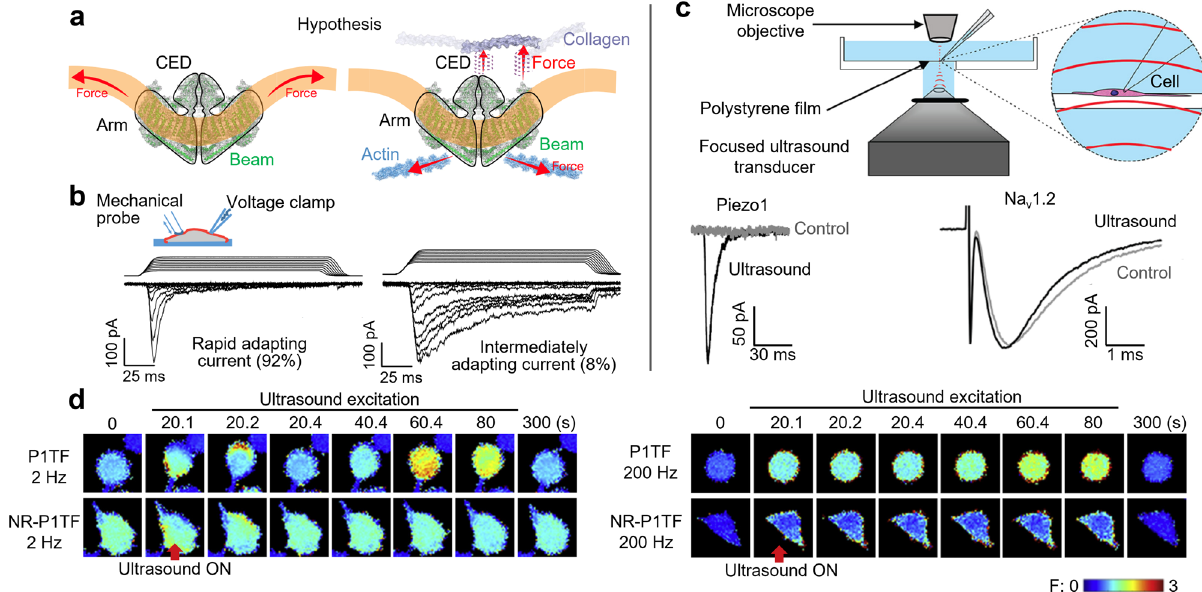
Fig. 2 Acoustic technologies for mechanobiology. Acoustic technologies are being utilized to study mechanically sensitive ion channels, such as Piezo1 and Piezo2. a Two models have been proposed for activation of the Piezo1 channel: the lateral membrane tension model (left), in which tension in the membrane leads to a gating force, and the tethered spring model (right), in which the activation of the channel is governed by interactions with the extracellular matrix. b Representative traces showing how traditional mechanical activation is used to study the dynamics of mechanosensitive neurons. A force is applied to the cell membrane using a glass probe, while another pipette is used to perform simultaneous patch-clamp current measurements in a whole-cell con fi guration. 92% of the neurons studied responded with a rapidly adapting current (inactivation time <10 ms), while 8% responded with an intermediately adapting current (10 ms < inactivation time <30 ms). c Ultrasound can be used to activate the mechanosensitive Piezo1 channel and the voltage-gated sodium channel NaV1.2 and make simultaneous patch-clamp recordings. d Ultrasound can also be used to target Piezo1-transfected (P1TF) HEK293T cells and investigate the intracellular calcium response under different pulse conditions. Fluorescence images show the intracellular calcium response of both responsive P1TF cells and non-responsive P1TF cells (NR-P1TF) under different pulse repetition frequencies. Part a adapted with permission from ref. 7 , Springer Nature. Part b adapted with permission from ref. 8 , Springer Nature. Part c adapted with permission from ref. 11 , Elsevier. Part d adapted with permission from ref. 12 ,